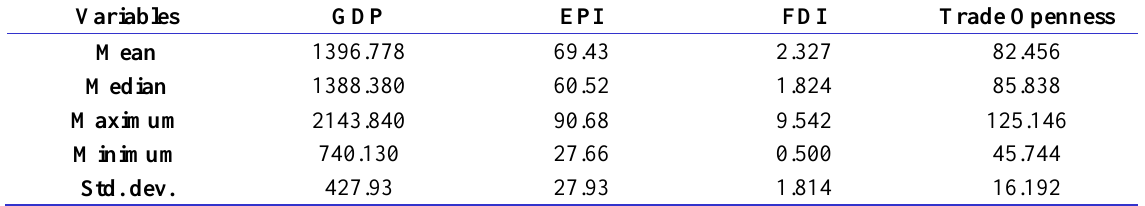
Table 1. A summary of the variables’ statistics